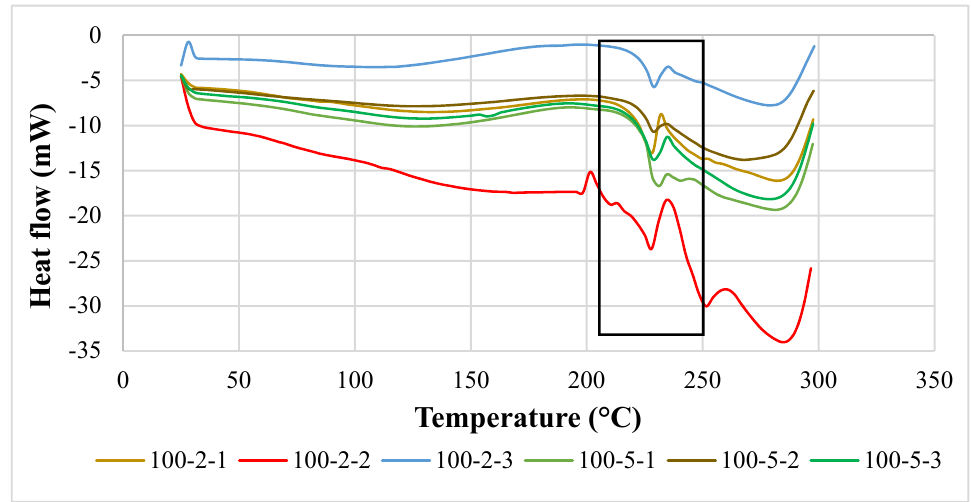
Figure 2. DSC thermogram of PVOH-calcined cuttlebone-MMT composites. Note: 100-2-1 denotes 100 phr PVOH added with 2 phr cuttlebone and 1 phr MMT.